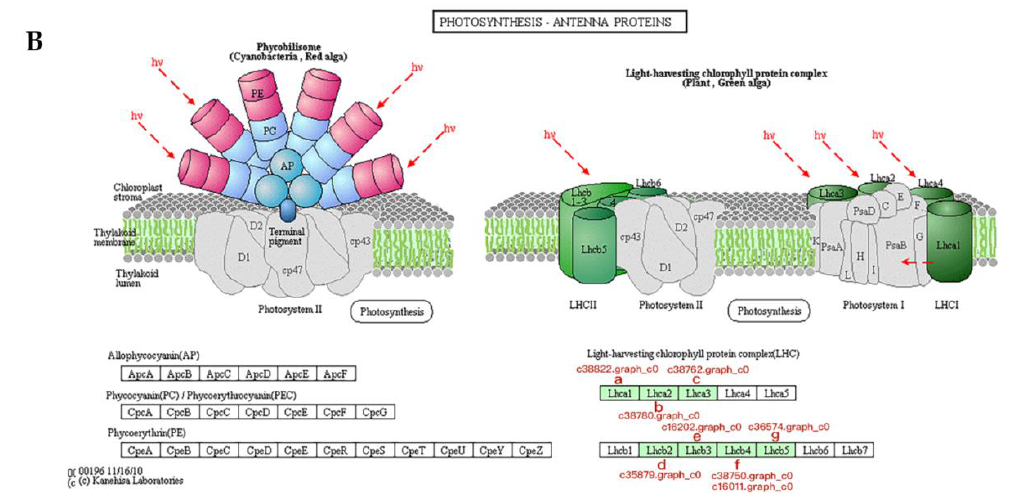
Figure 8. Maps of photosynthesis and photosynthesis-antenna proteins pathways: ( A ) photosynthesis pathway; and ( B ) photosynthesis-antenna proteins pathway. ( A ) The green background rectangles on the left side of the graph represent the identified proteins with differential abundance. The right side of the graph is the enlarged image of the important part, and the proteins with differential abundance are labeled with accession no. ( B ) The green background rectangles represent the identified proteins with differential abundance and labeled with accession no. Definition of proteins indicated in Figure 8A: a: PsbO 1, photosystem II oxygen-evolving enhancer protein 1; b: PsbQ 3,